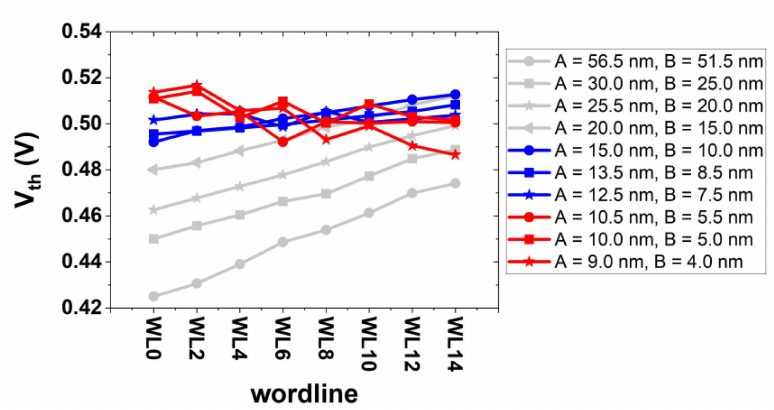
Figure 8. Estimated threshold voltage of bit cells from the bottom side (w0) to the top side (w14) for a given string. Depending on the channel radius (A), the threshold voltage (V th ) of the bottom cell is either higher or lower than V th of the top cell (e.g., for A = 20.0~56.5 nm (for A = 9.0~10.5 nm), V th of the bottom cell is lower (higher) than V th of the top cell). The non-monotonic decrease of V th for all bit-cells with A of 10.0 nm can be understood due to the peaked-out value of the eDensity for a few bit-cells placed in the middle of the string.